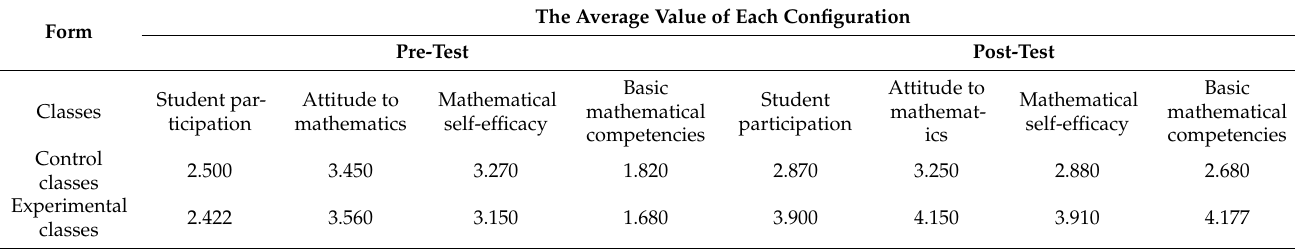
Table 11. Comparison of pre-and post-test means between the experimental and control